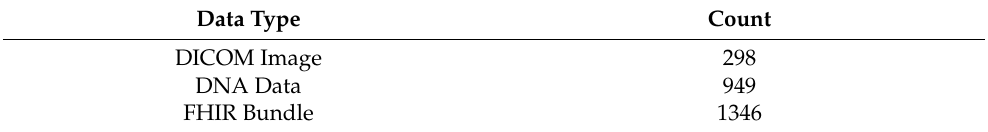
Table 1. Count of files by data types for all synthetic patients in the Coherent Data Set.